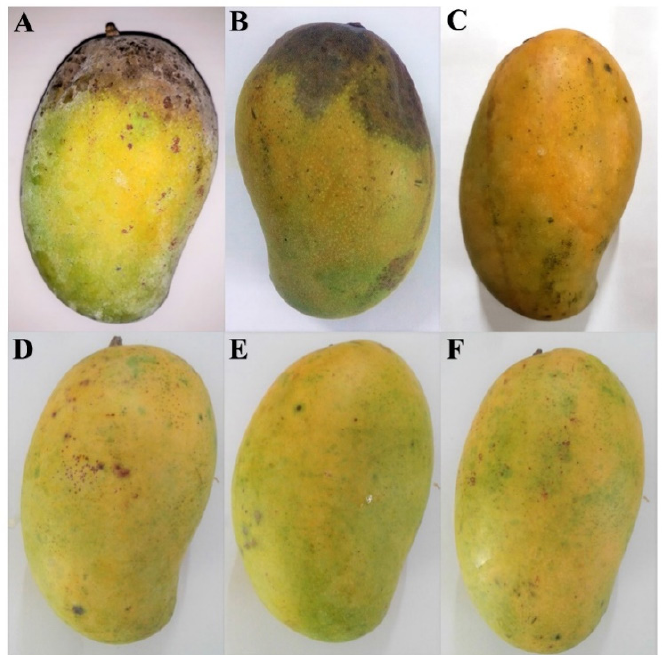
Figure 1: Appearance of mango cv. ‘Karthakolomban’ subjected to dip treatments, stored at 12 - 14 ℃ for 10 d and after induced ripening. A. distilled water B. distilled water + gelatin C. 0.1% carbendazim D. Aloe vera gel E. Aloe vera gel + 2.0 µL/mL cinnamon leaf oil F. Aloe vera gel + 2.0 µL/mL cinnamon bark